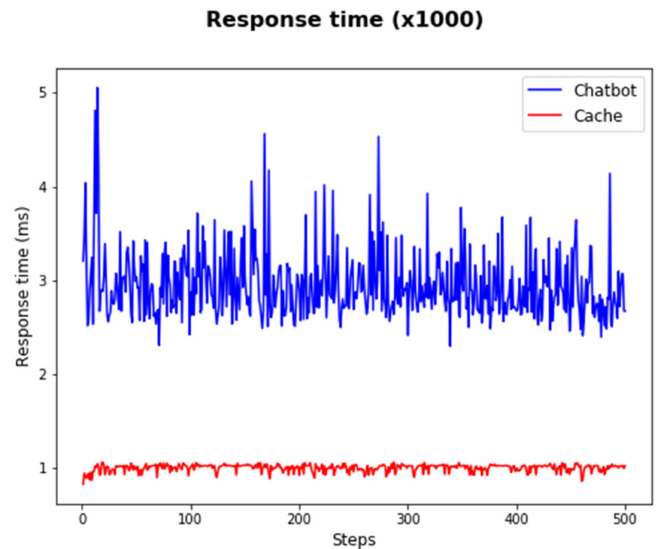
Figure 10. Experimental results for response